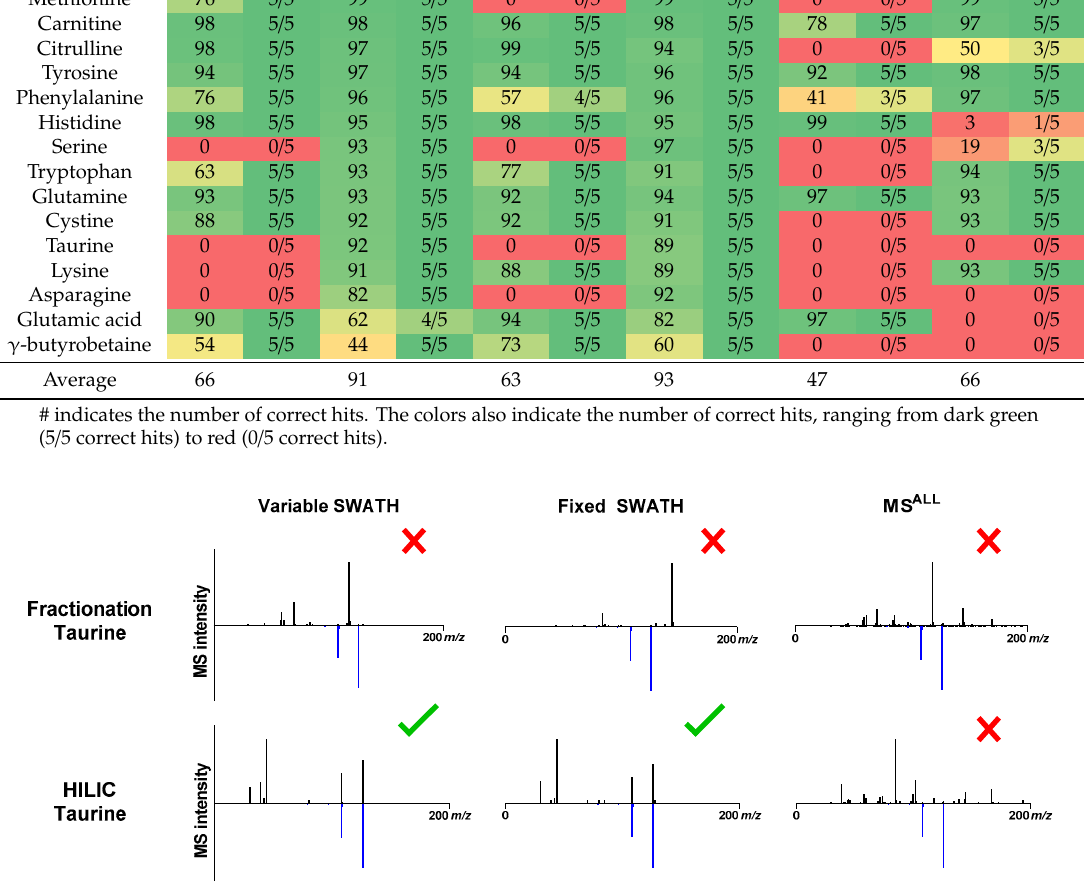
Figure 4. Experimental (black) and NIST library (blue) MS / MS spectra comparison measured in positive ionization mode. The HILIC separation in combination with SWATH resulted in the assignment of the correct structure.